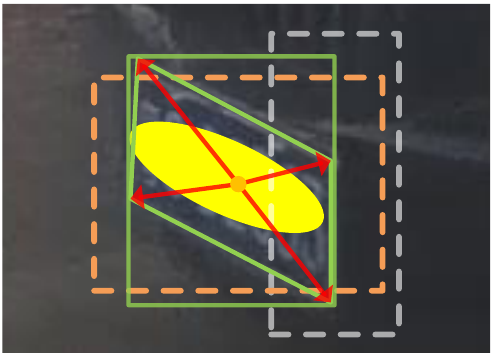
Figure 3. The four corners of the license plate are regressed based on the offsets (red arrow) from the center (orange circle) of the matched anchor box (dashed orange rectangle). The matched anchor box is determined by the intersection over union (IoU) with the horizontal ground-truth box (solid green rectangle). The negative anchor box (dashed gray rectangle) is neglected due to low IoU. The license plate is manually covered with a yellow ellipsoid to protect